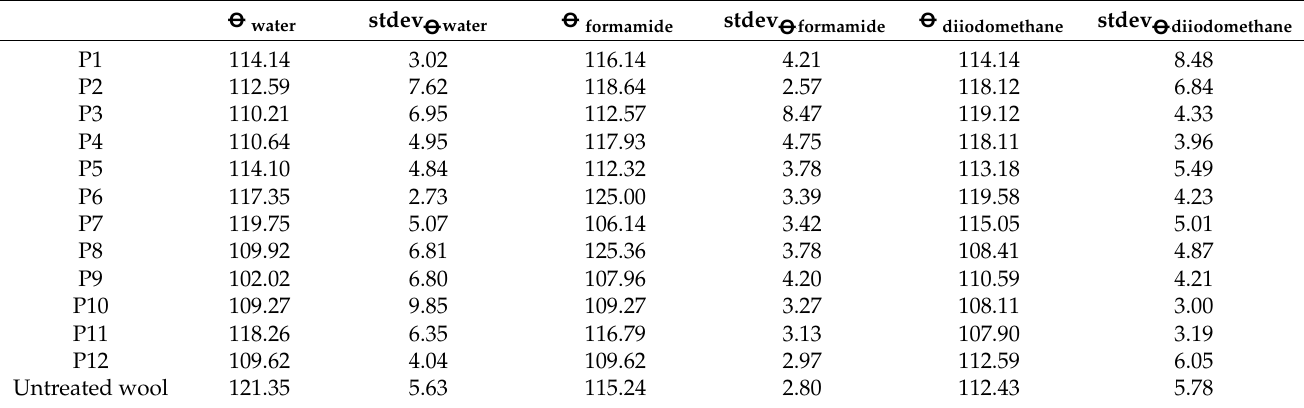
Table 5. The values of contact